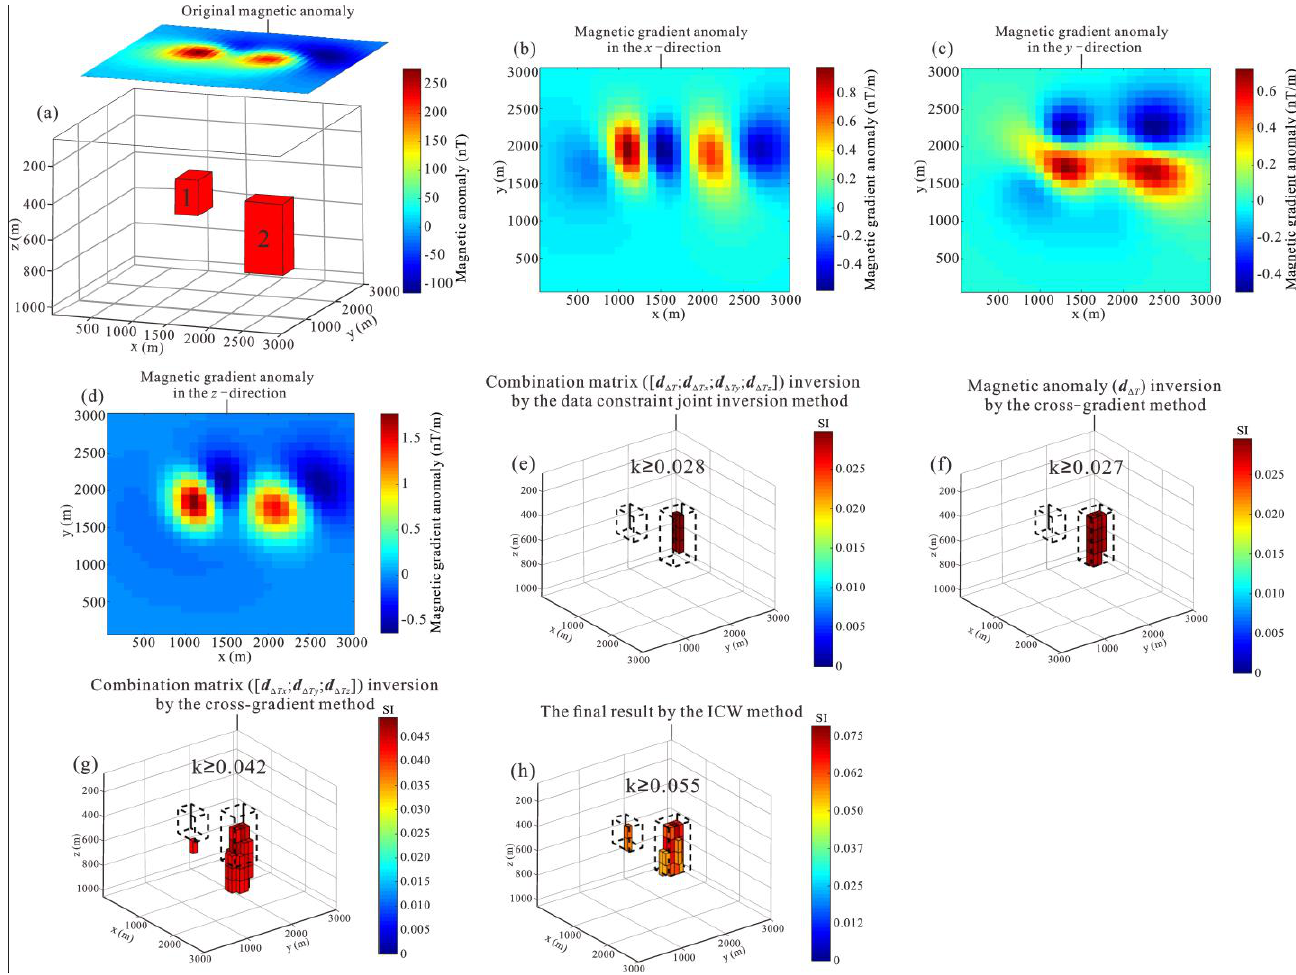
Figure 6. Magnetic and gradient anomalies (compared with the model in Figure 2, the buried depths of the prisms are increased by 100 m) and the volume-rendered images by different methods. ( a ) 3D view of 2 prisms and magnetic anomaly. ( b ) Magnetic gradient anomaly in the x -direction. ( c ) Magnetic gradi- ent anomaly in the y -direction. ( d ) Magnetic gradient anomaly in the z -direction. ( e )